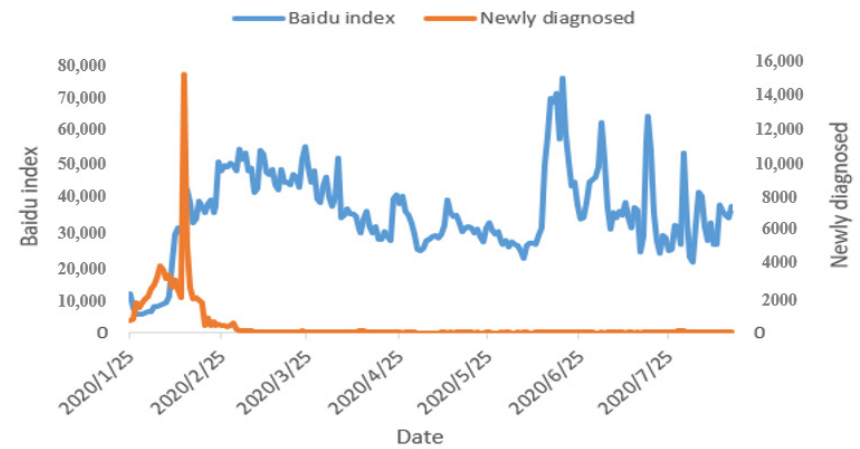
Figure 4. COVID-19’s Baidu index (blue) and the number of newly diagnosed cases (orange).